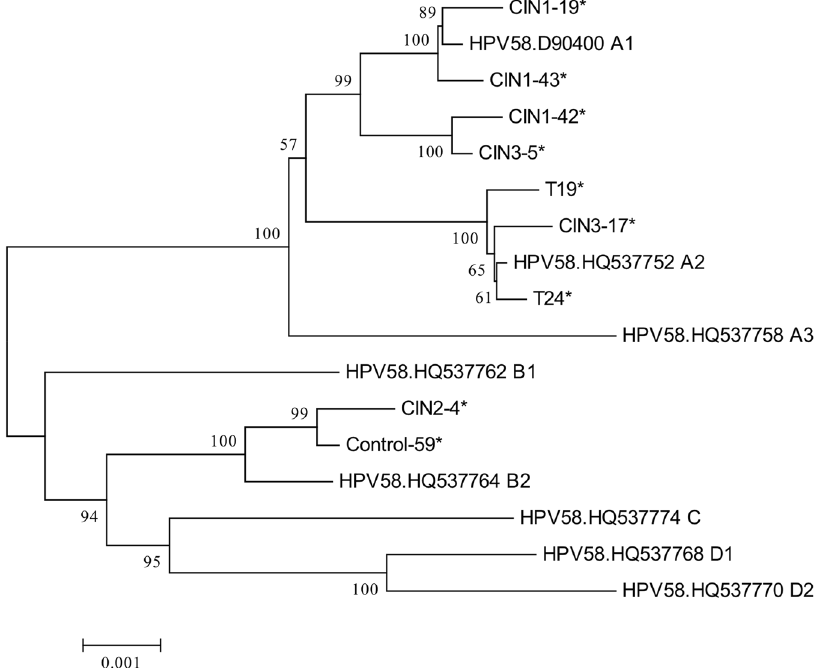
Figure 3. Phylogenetic tree based on whole-genome analyses of 9 HPV58-positive samples and 8 published representative HPV58 variant lineages and sublineages from the Genbank database. Phylogenetic analyses were conducted using the neighbor-joining algorithm implemented in MEGA software (version 6). Bootstrap analysis of 1000 replicates was performed on each tree to determine the confidence. Study sequences in the phylogenetic trees were marked with an asterisk.